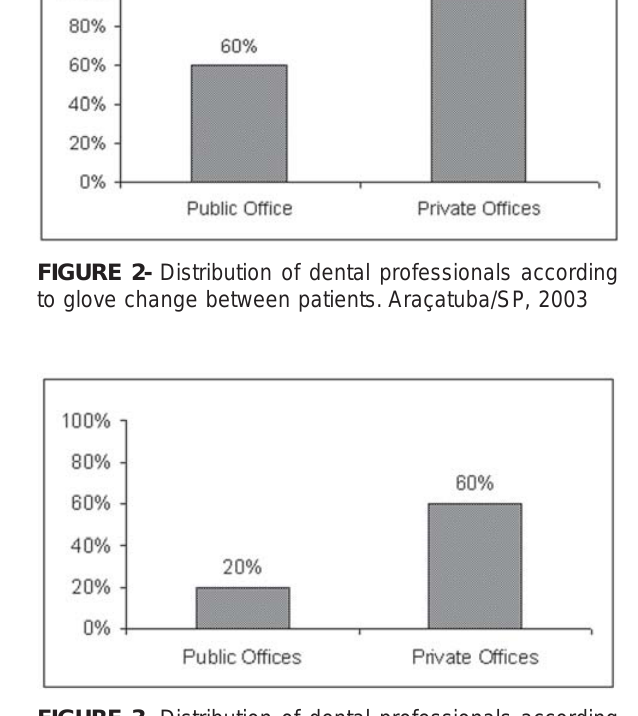
FIGURE 3- Distribution of dental professionals according to the use of shields for high- and low-speed turbines and air-water syringe. Araçatuba/SP, 2003